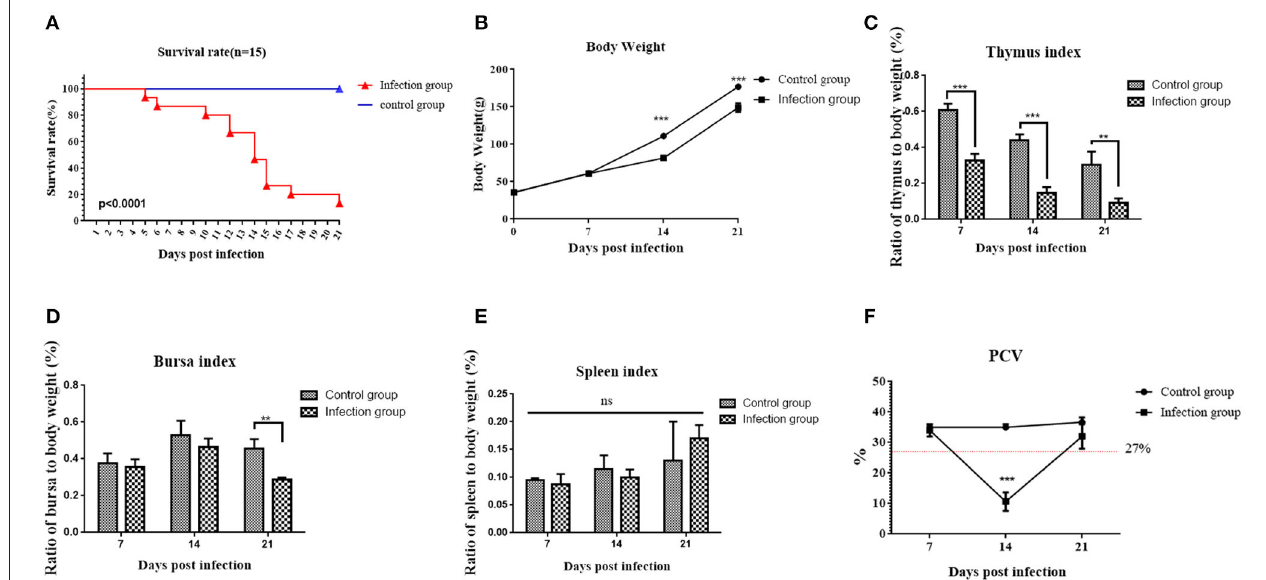
FIGURE 3 | Detection of survival rate, body weights, immune organs indices, and packed cell volume (PCV) at various detected time points. (A) Survival rates of the control group and infection group of chicks ( n = 15). Curves are significantly different ( p < 0.001) by log-rank test and Gehan-Breslow-Wilcoxon analysis. (B) Chicken body weights in the control and infection groups. (C) Thymus index (the ratio of thymus to body weight) in the control and infection groups. (D) Bursa index (the ratio of bursa to body weight) in the control and infection groups. (E) Spleen index (the ratio of spleen to body weight) in the control and infection groups. (F) Detection of PCV (hematocrit values) at various detected time points. A PCV value below 27% was regarded as anemia. The unpaired t -test was used for statistical comparison. Statistical significance was assessed at P -values. ns P > 0.05, ** P < 0.01, *** P < 0.001.